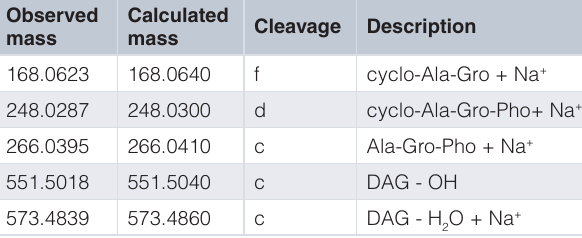
Table 2. Accurate masses of fragments from alanyl-PG.